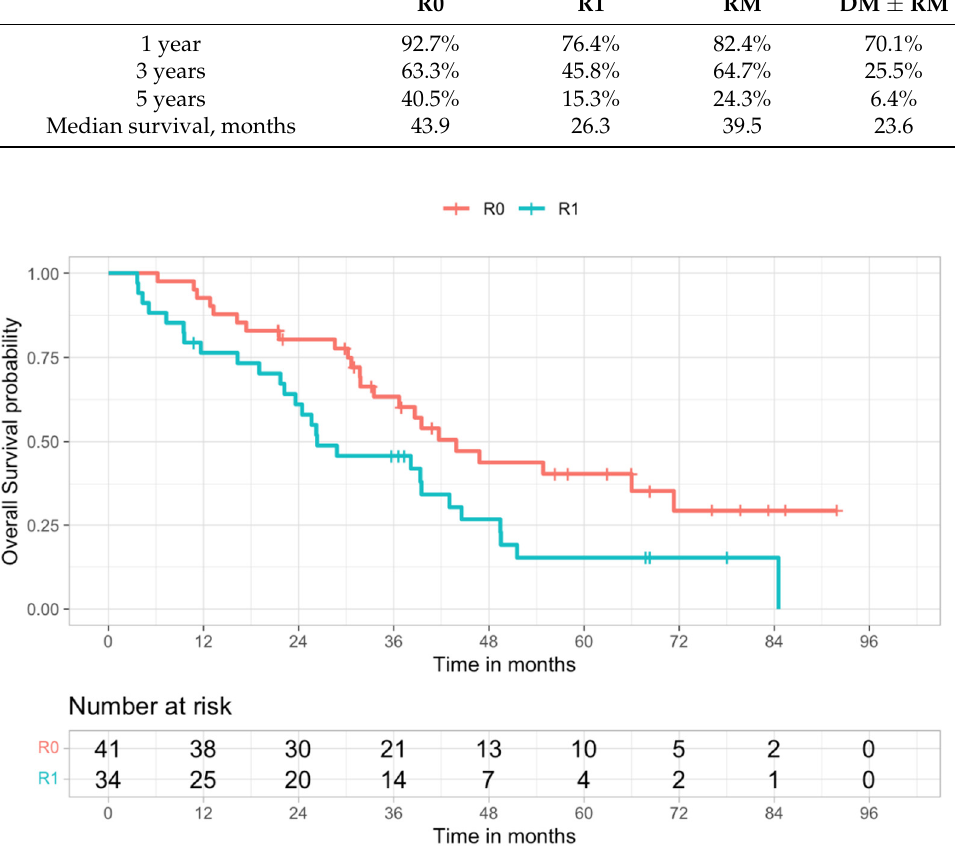
Figure 1. Kaplan–Meier overall survival curves of R0 and R1 populations (log-rank test, p = 0.019). Upon further analysis, it was found that overall survival was not significantly different between the R0 and RM groups ( p = 0.361), nor between the RM and DM ± RM groups ( p = 0.113). A significant difference in survival was found between the R0 and DM ± RM groups ( p = 0.004) (Table 3 and Figure 2).